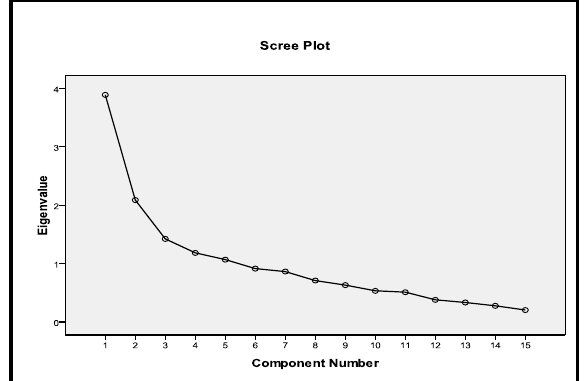
Fig. 1. Scree plot for Attractive